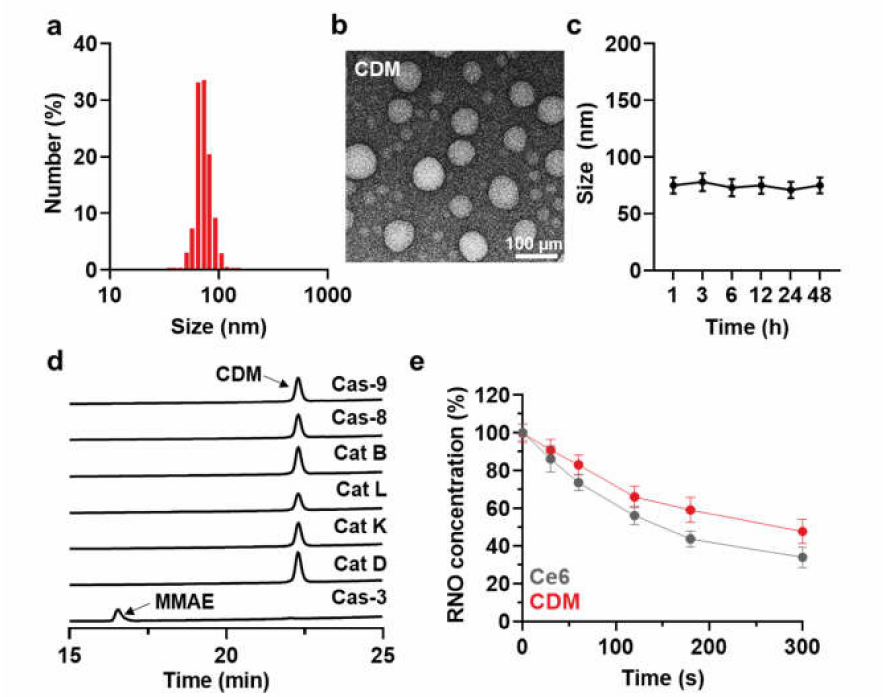
Figure 2. Physicochemical characterization of CDM. ( a ) Size distribution of CDM in aqueous condition (saline; 1 mg/kg). ( b ) TEM image showing spherical morphology of CDM. ( c ) Stability of CDM nanoparticles in saline. ( d ) Target enzyme-specific cleavage of CDM was assessed after incubation with caspase-3 and various other enzymes. ( e ) ROS generation of CDM or Ce6 in the presence of visible light